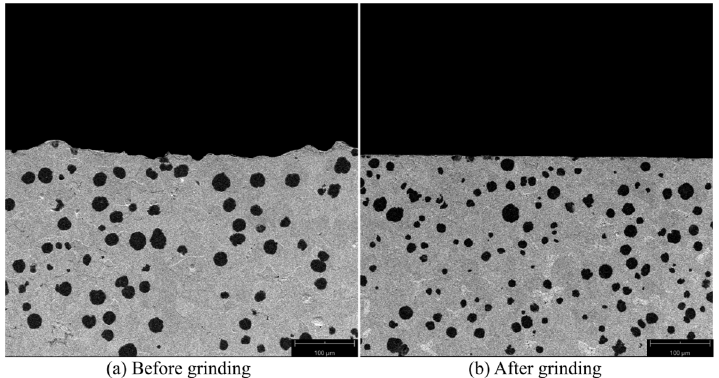
Figure 14. SEM image of sample surface (500 × ): ( a ) Sample surface before grinding, ( b ) Sample